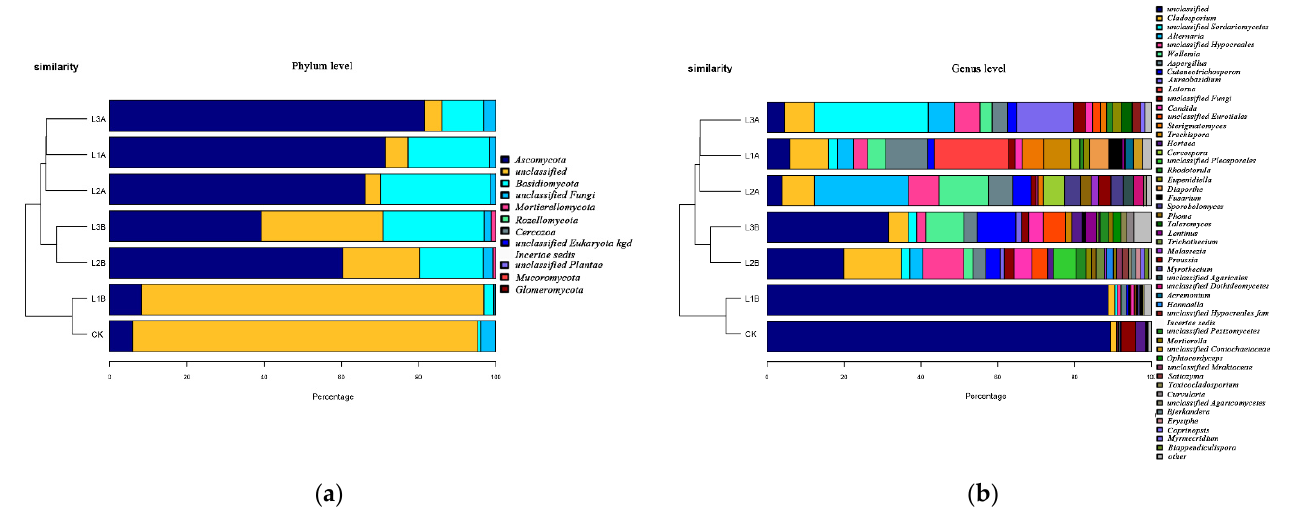
Figure 6. Effects of C. vulgaris LH-1 supplementation on fungal communities in seawater with 0.01 g/L crude oil and different nutrient concentrations. ( a ) Phylum Level. ( b ) Genus Level.